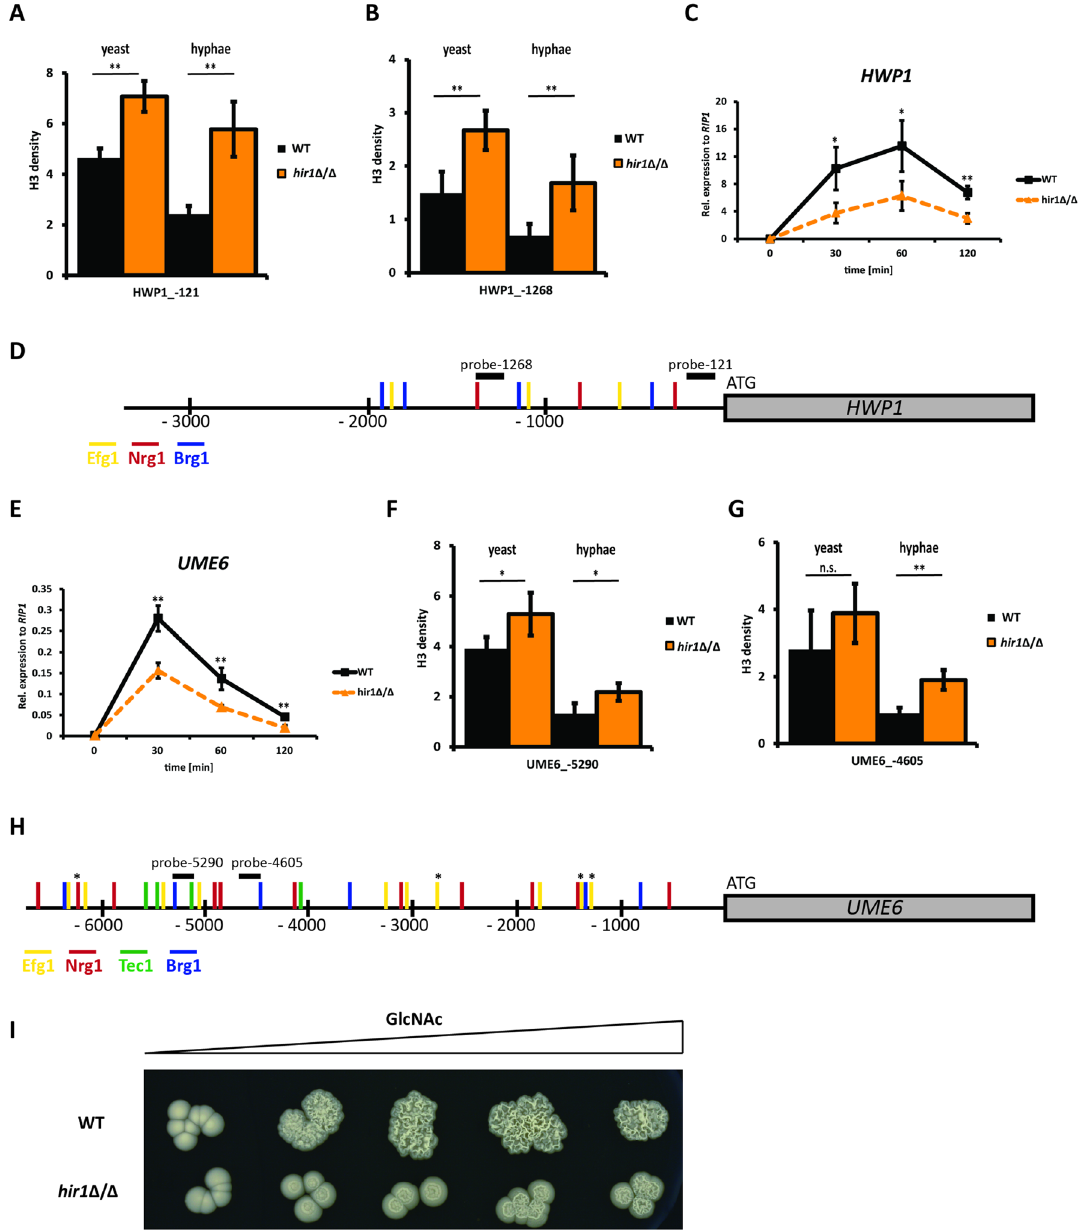
Figure 5. Hir1 affects the chromatin density in the HWP1 and UME6 promoter. ( A , B ) Loss of HIR1 increases the histone density in the HWP1 promoter. Histone density was measured using histone H3 ChIP and qPCR at different HWP1 promoter regions. ( C ) HWP1 expression is reduced in hir1 Δ / Δ cells. WT and hir1 Δ / Δ cells were grown in YPD with 10% FCS at 37 °C. Cultures were collected at the indicated time points followed by RNA extraction. Gene expression of HWP1 was measured via RT-qPCR and transcript levels were normalized to the reference gene RIP1 . ( D ) Representative illustration of transcription factor binding sites in the HWP1 upstream intergenic sequence. Efg1 (yellow) and Nrg1 (red) binding motifs were taken from ref. 59 and Tec1 (green) and Brg1 (blue) from ref. 13. Note that no putative Tec1 binding site was identified in our in silico scan. (E) The same as in ( C ), but for UME6 . ( F , G ) Genetic removal of HIR1 alters histone occupancy at distinct UME6 promoter regions. Histone density was measured using histone H3 ChIP and qPCR at different UME6 promoter regions. ( H ) Putative transcription factor binding sites for the upstream intergenic region of UME6 are represented as in ( D ). Transcription factor sites with asterisk ( * ) indicate multiple sites for a given regulator within less than 100 bp. ( I ) HIR1- deficient cells require stronger signal intensity to initiate hyphal formation. WT and hir1 Δ / Δ cells were spotted on YPD supplemented with a continuous GlcNAc concentration gradient of 0–10 mM. Colony morphology was inspected after growth for 3 days at 37 °C. ( A , B , F , G ) The qPCR signals from Input and IP were normalized to an intergenic region on chromosome R. The ratio of normalized Input/IP values is shown on the y-axis labeled as “H3 density”. ( A – C , E – G ): Data are presented as mean + SD of three independent experiments. For significance testing, hir1 Δ / Δ cells were compared to WT cells. * P < 0.05, ** P < 0.01 with Student’s